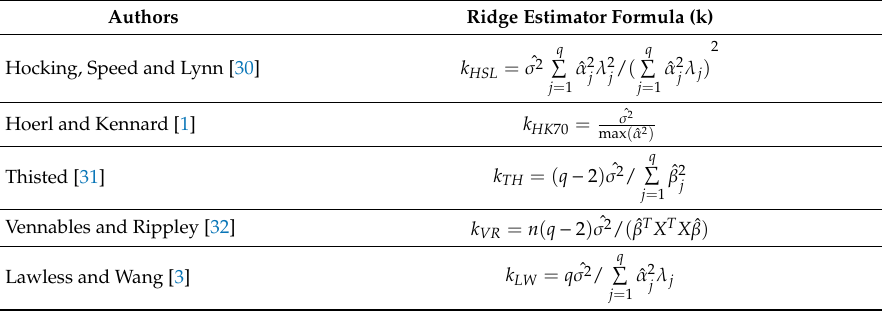
Table 1. Some ridge regression